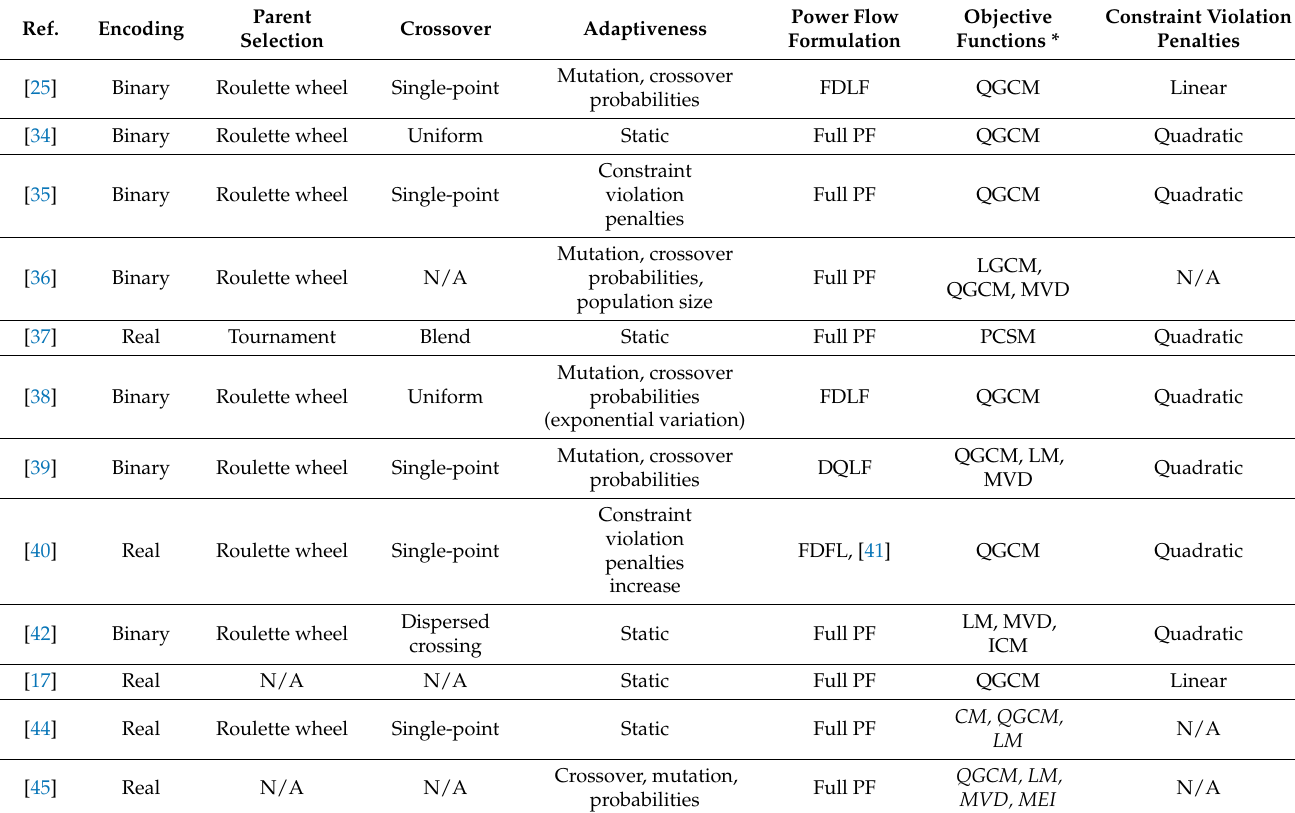
Table 3. Summary of the reviewed GA OPF